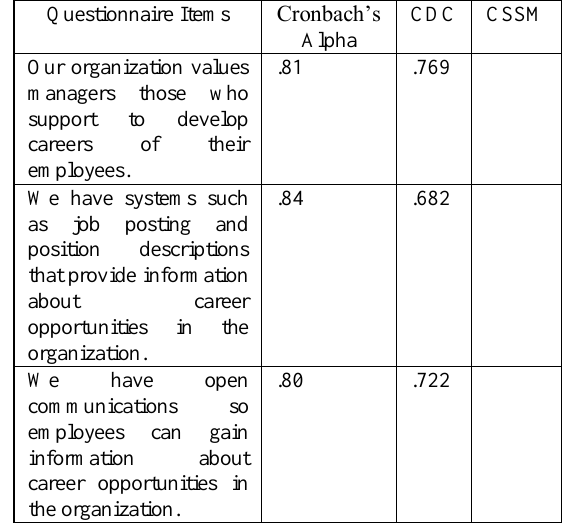
Table 4: Rotated Factor Loading